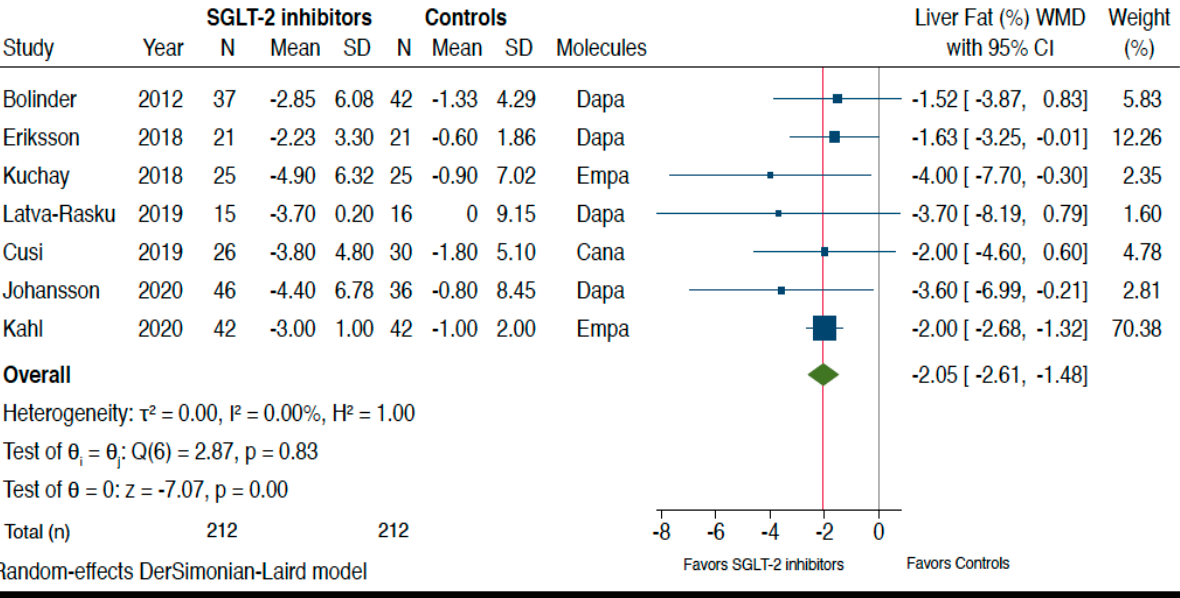
Figure 2. Forest plot of the effect of SGLT-2 inhibitors on the absolute percentage of liver fat content assessed by magnetic resonance-based techniques ( n = 7 RCTs using either magnetic resonance imaging-proton density fat fraction (MRI-PDFF) or magnetic resonance spectroscopy (MRS)). The effect size was expressed as weighted mean difference (WMD) and 95% confidence intervals for all RCTs included. Note: If not available, the SDs of the weighted mean difference were estimated using a specific formula (as reported in the Methods section). In the study of Bolinder et al. [19], the investigators reported only the placebo-corrected difference in mean percent MRI-PDFF with dapagliflozin.